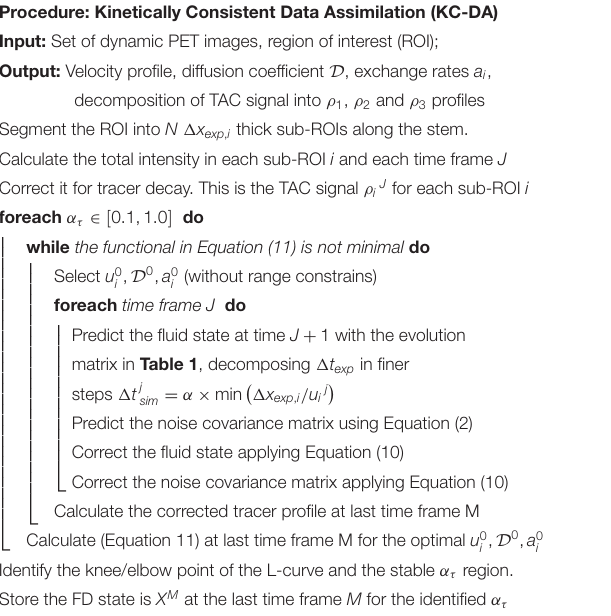
TABLE 3 | A schematic description of the implementation of the KC-DA procedure. Procedure: Kinetically Consistent Data Assimilation (KC-DA) Input: Set of dynamic PET images, region of interest (ROI); Output: Velocity profile, diffusion coefficient D , exchange rates a i , decomposition of TAC signal into ρ 1 , ρ 2 and ρ 3 profiles Segment the ROI into N 1 x exp , i thick sub-ROIs along the stem. Calculate the total intensity in each sub-ROI i and each time frame J Correct it for tracer decay. This is the TAC signal ρ i J for each sub-ROI i foreach α τ ∈ [ 0.1,1.0 ] do